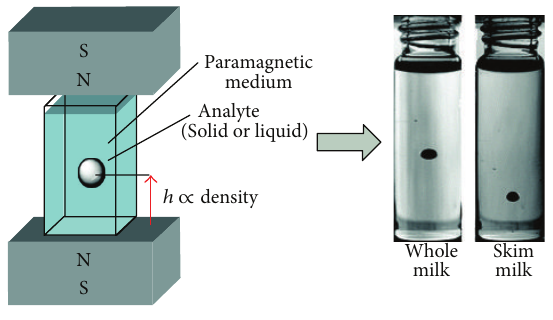
Figure 28: Maglev